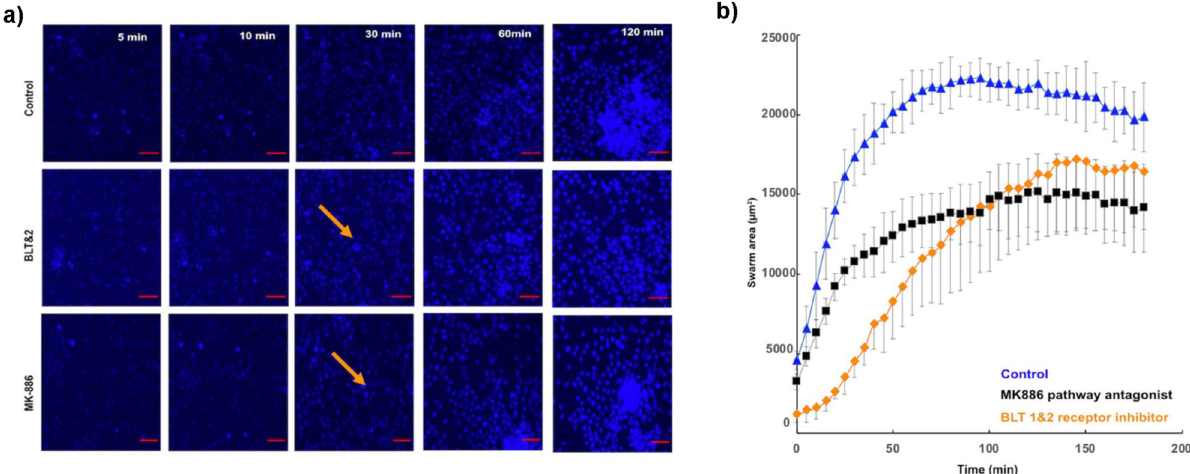
Figure 8. Disrupted migration of DdHL-60 towards swarm in the presence of BLT1 receptor antagonist and LTB4 synthesis inhibitor. ( a ) Sequential images showing swarm formation in Control, BLT1&2 receptor antagonist and LTB4 pathway antagonist around patterned zymosan particle clusters at 5mins, 10mins, 30mins, 60mins and 120 min (scale bar 25 µm). Orange arrows showing delay in initiation. ( b ) dHL-60 form smaller swarms that grow slower in the presence of BLT1 antagonists and LTB4 pathway inhibitors [Blue (triangle) curve: Control, Black (square) curve: LTB4 pathway antagonist MK-886, Orange (diamond) curve: BLT1&2 receptor antagonist]. Each group was measured in four separate spots in a field of view. Error bars represent standard deviations for these measurements. Figure shows representative experiments of N = 36 fields of view (4 spots per